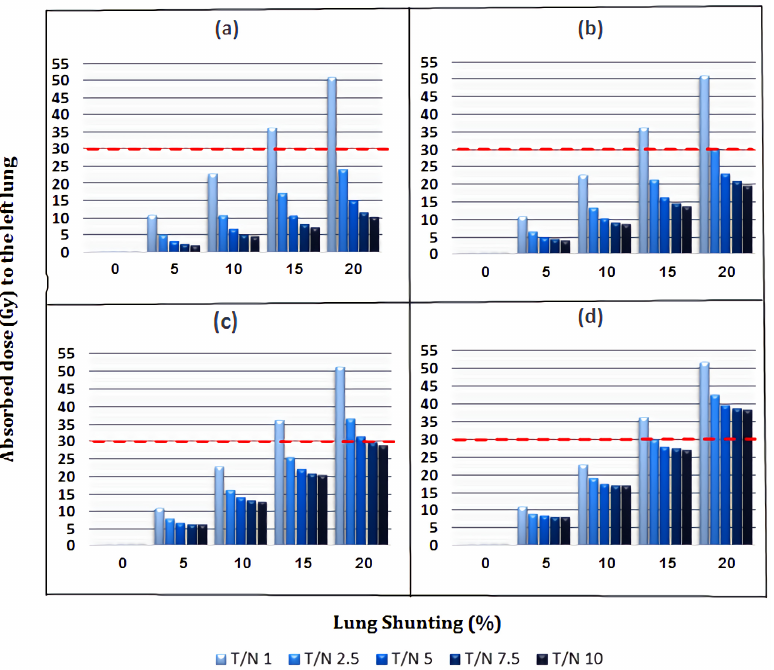
Figure 7. Absorbed dose to the left lung for various TIs of ( a ) 10, ( b ) 30, ( c ) 50, and ( d ) 70%, LS, and T/N, when 120 Gy is delivered to the tumour. The red dotted lines indicate the maximum dose limit to lungs of 30 Gy.